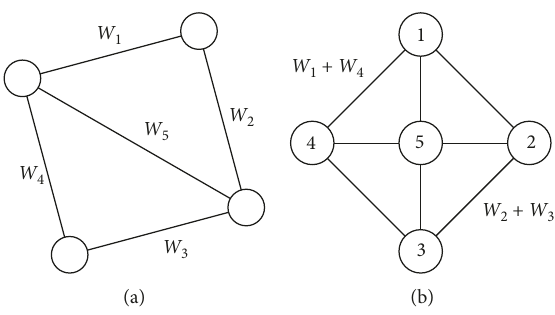
Figure 3: (a) Weighted base graph. (b) Weighted line